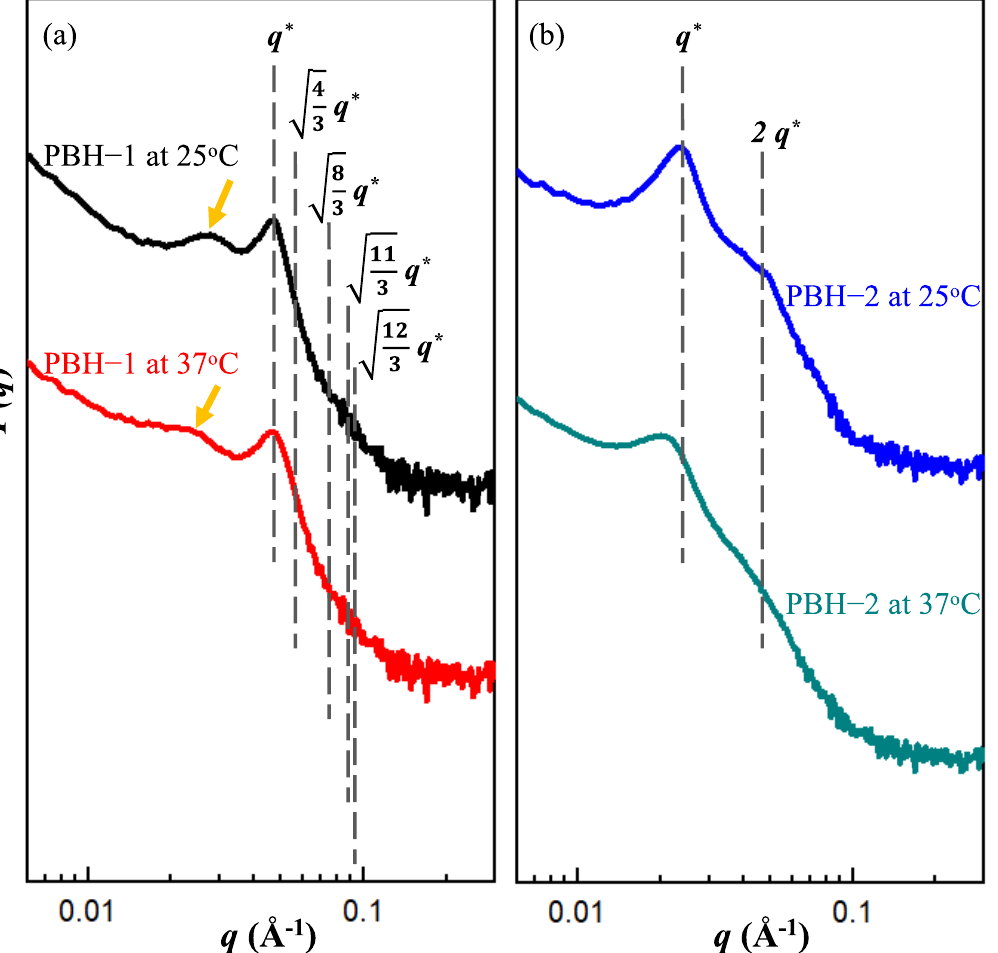
Figure 4. SAXS 1D profiles (offset for clarity, arbitrary intensity units) of the pluronic biomedical hydrogels ( a ) PBH-1 and ( b ) PBH-2, respectively at 25 °C and 37 °C. The black dotted lines serve as a guide for the eyes and the yellow arrow indicates the scattering peak of aggregated micelles.